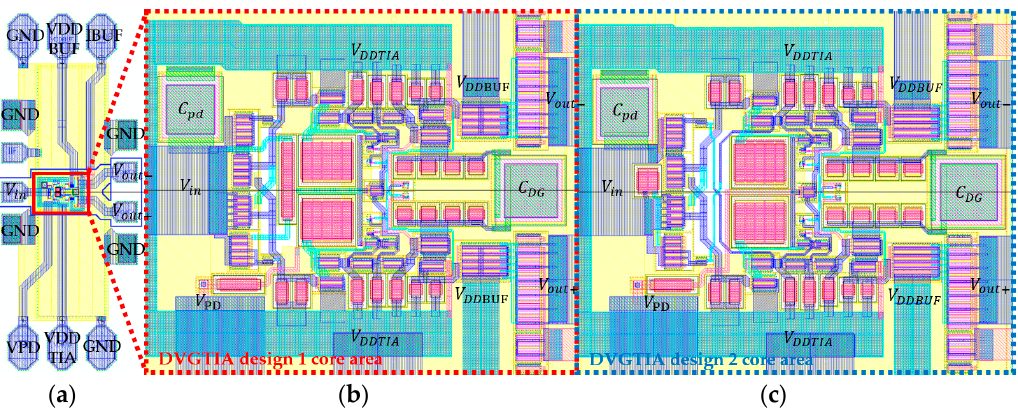
Figure 6. ( a ) TIA layout design with pads and ( b ) core area only of DVGTIA design 1 and ( c ) DVGTIA design 2 (both core area: 100 µm × 85 µm, total area with pads: 350 µm × 910 µm).